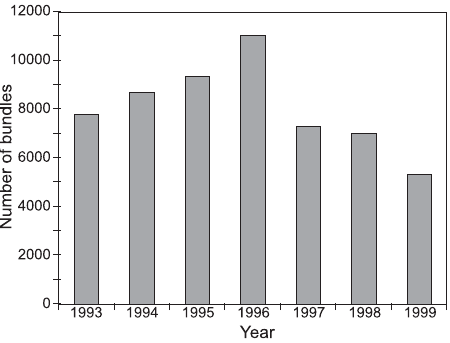
Fig. 1. Annual reed harvest from the Muzi Swamp from 1993 to 1999 (Kyle 2000).